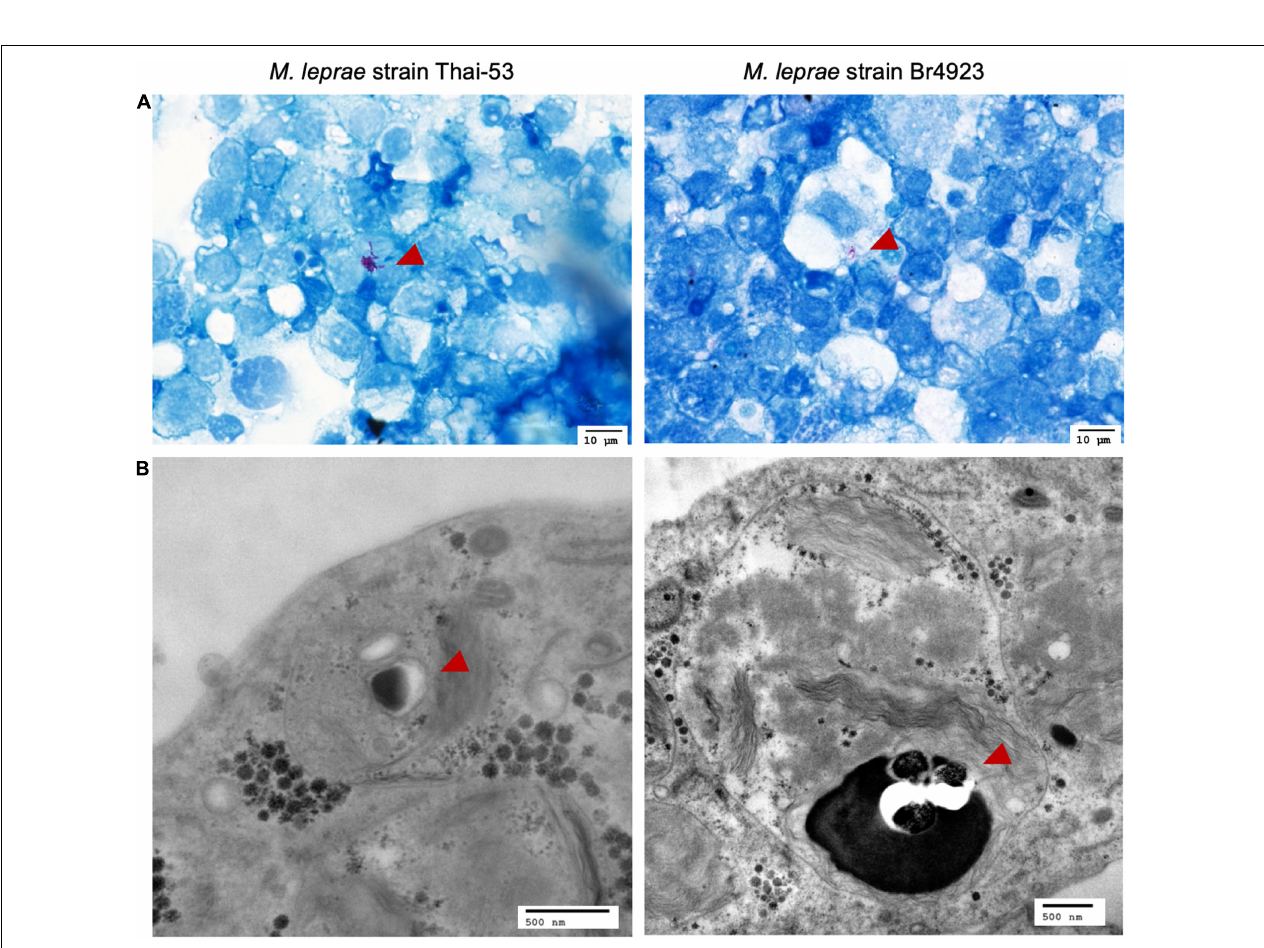
FIGURE 5 | Visualization of M. leprae -infected tick cells by light microscopy and TEM. ISE6 cells infected with M. leprae Thai-53 and Br4923 strains for over 700 days were visualized but light microscopy at magnification 60 × after (A) Fite’s acid fast staining and (B) by TEM. Bacilli are indicated by red arrowheads.